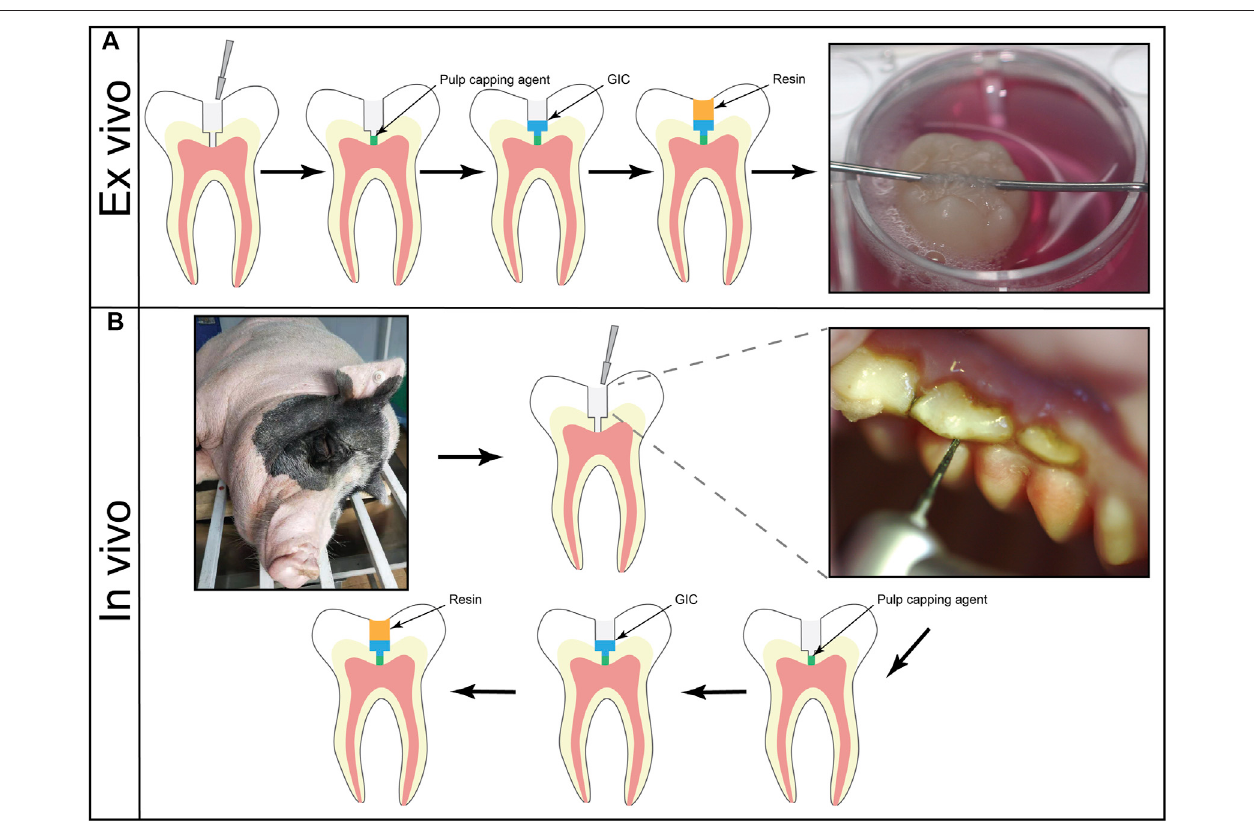
FIGURE 1 | (A) Schematic of pulp-capping procedure of ex vivo human tooth culture model. The class-I cavities were prepared on the occlusal surface. After the application of pulp capping agents, restoration was fi nished by glass ionomer cement and light-curable restorative resin. (B) Schematic of pulp-capping procedure of in